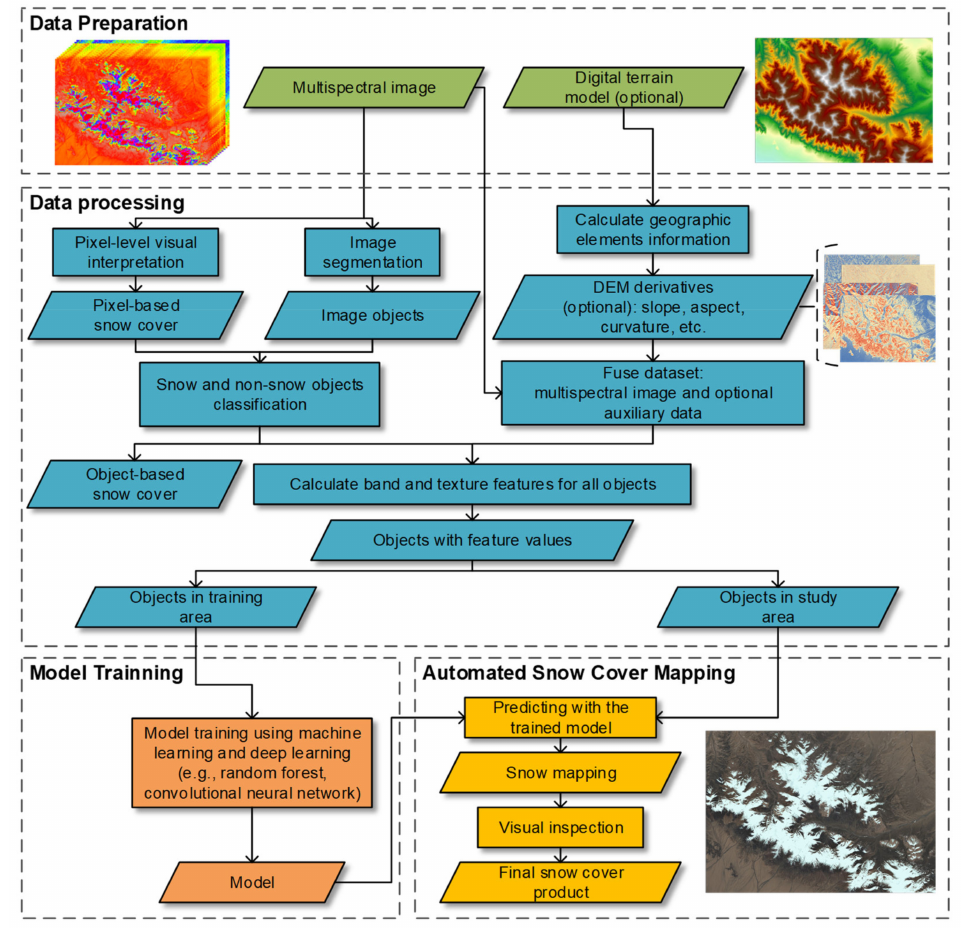
Figure 4. Framework of AutoSMILE (automated Snow Mapper Powered by Machine